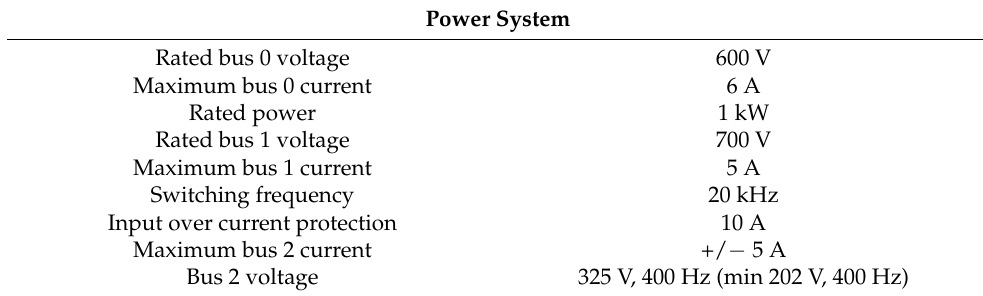
Table 1. Electrical parameters of the on-board